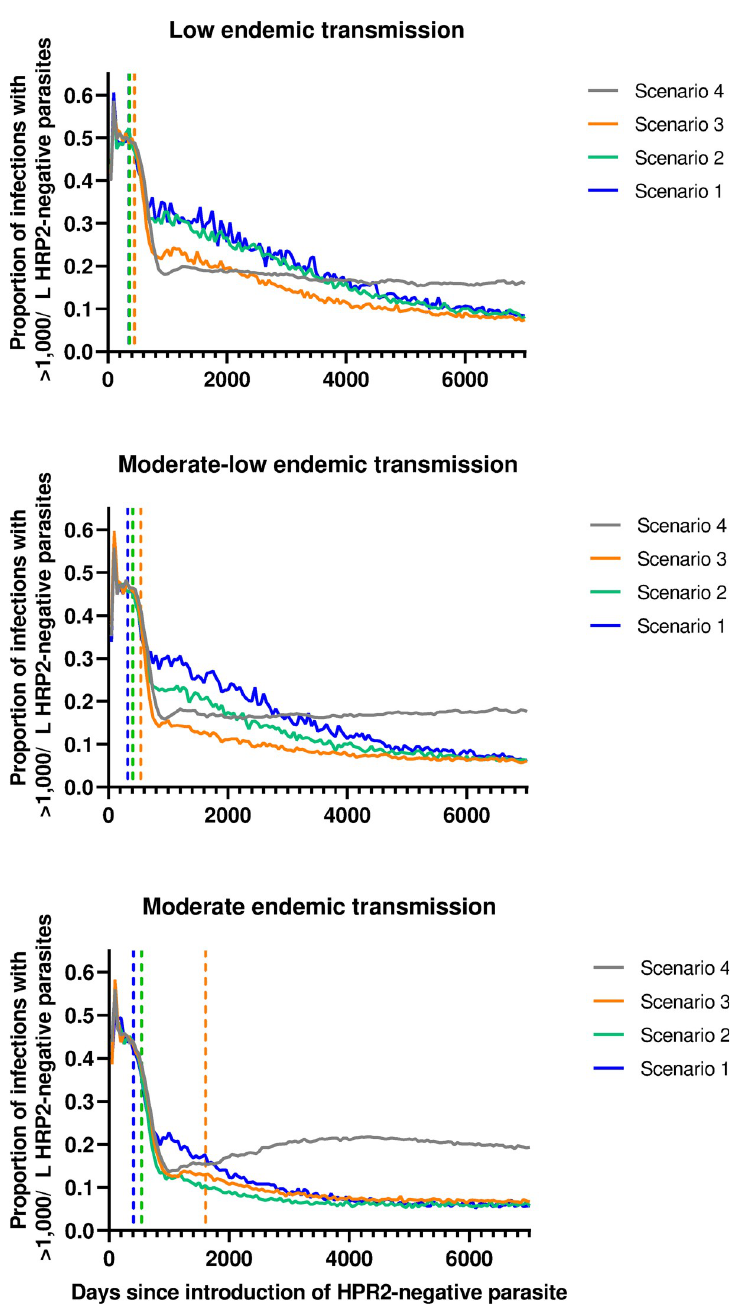
Fig 2. Average proportion of all infections ( > 10/ μ L) containing the HRP2-negative phenotype which were high density ( > 1,000/ μ L). Proportions are calculated within individual simulations, then averaged across simulations. Vertical reference lines indicate the median RDT change day for Scenarios 1, 2 and